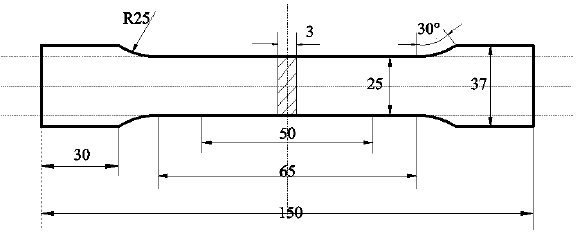
Figure 7. Specimen sampling position.